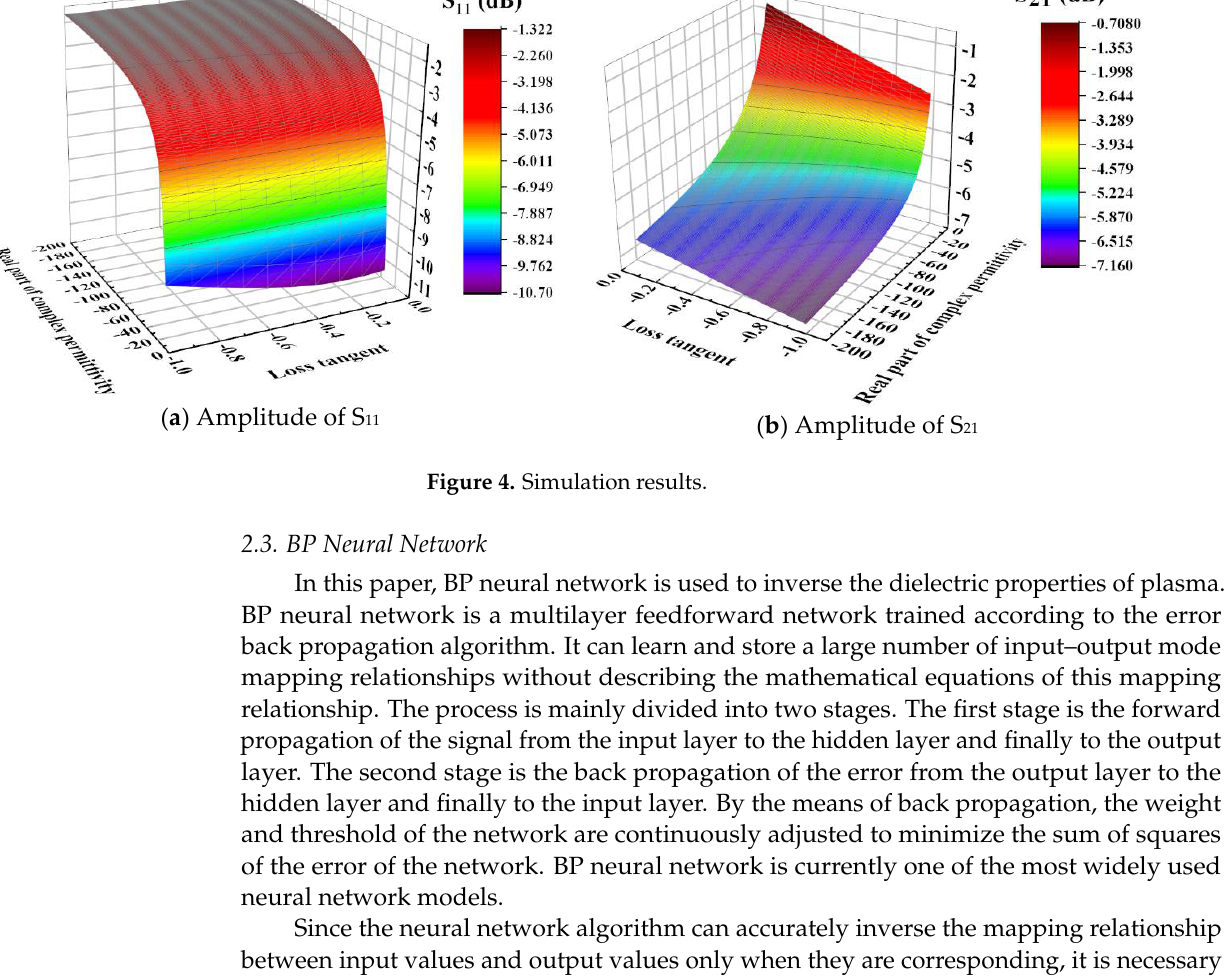
Table 1. Parameter scan settings.